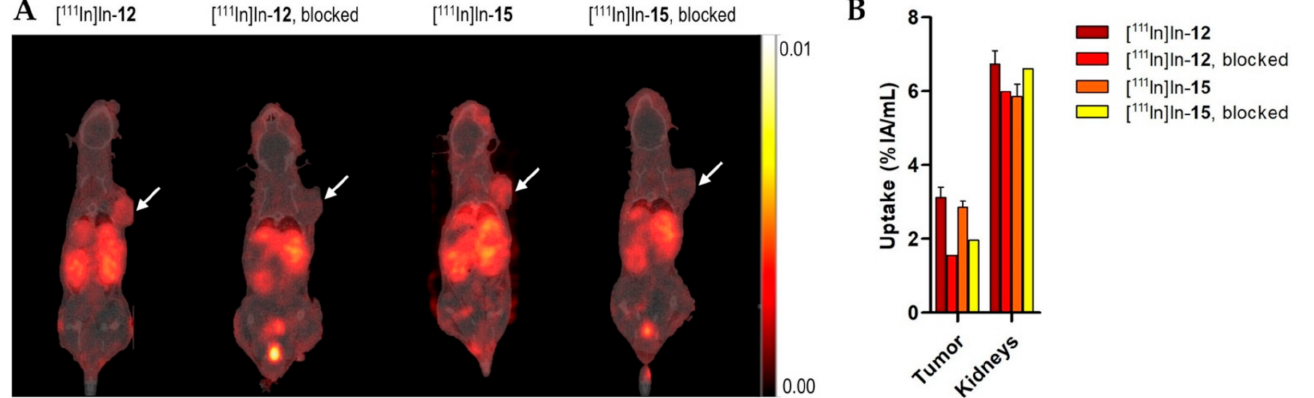
Figure 2. SPECT/CT imaging of [ 111 In]In- 12 and [ 111 In]In- 15 in PC-3-xenograft Balb/c nu/nu mice, 2 h p.i. ( A ) SPECT/CT images: overlay of a CT slice and the corresponding SPECT slice, on which the tumor cross-section is distinctly visible. The tumor is located on the right shoulder (white arrow). For the non-blocked groups, one representative image is shown. ( B ) Radioactivity uptake in tumor and kidney volumes of interest, determined from SPECT images, is expressed as a percentage of injected activity per mL (%IA/mL). The values for the unblocked groups are recorded as mean ± SD ( n =